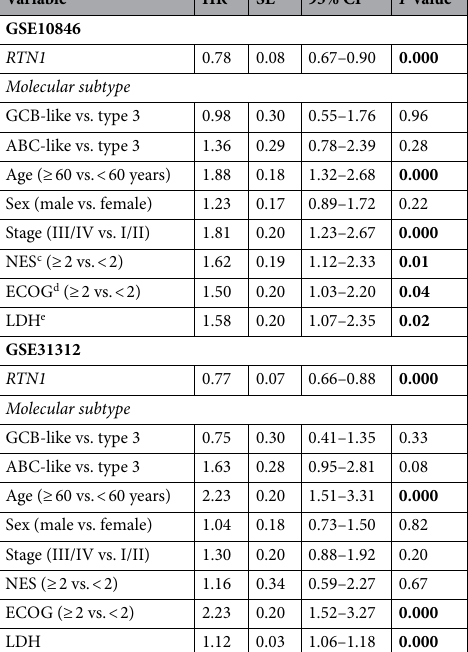
Table 2. Multivariate analysis of the RTN1 and common prognostic variables in DLBCL (the IPI components). The RTN1 gene was remained as a one of the most powerful independent prognostic factor. Significant P values were bolded. a Hazard ratio, b Hazard ratio 95% confidence interval, c No. of extranodal sites, d ECOG performance status, e Lactate